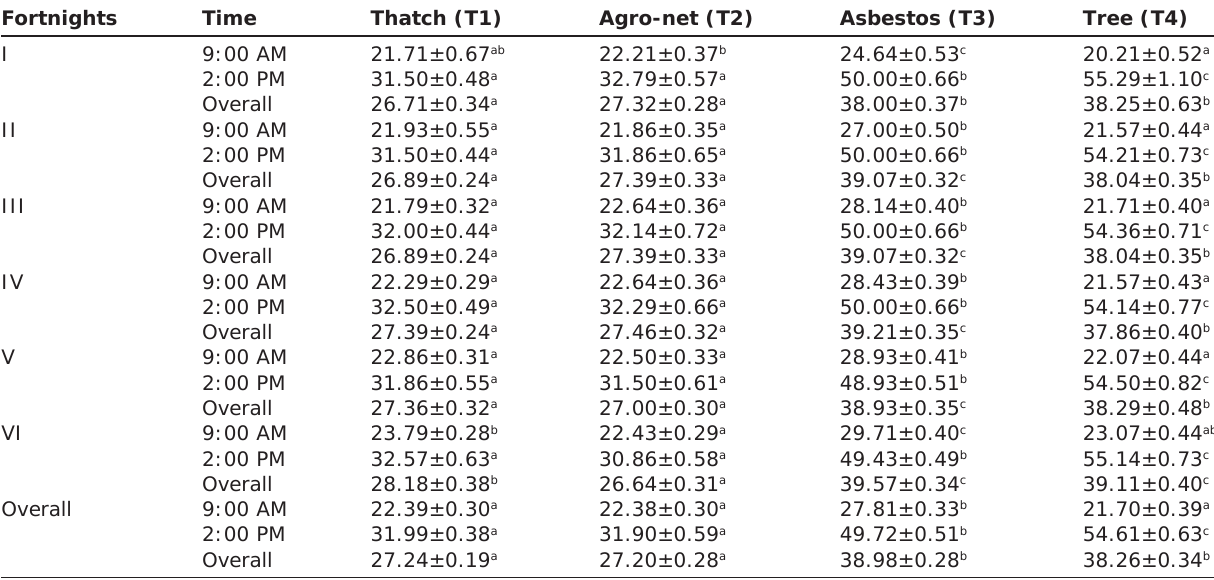
Table-3: Mean±SEM of respiration rate (per minutes).